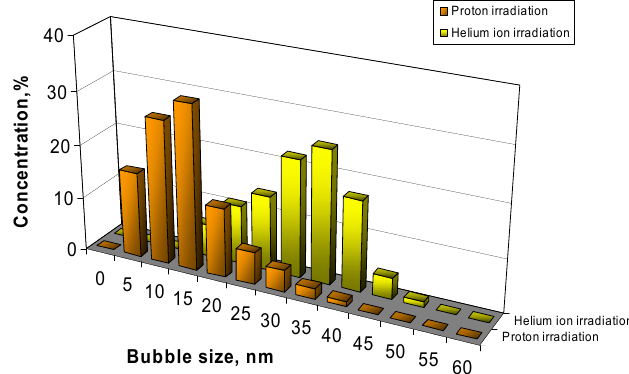
Figure 3. Diagram of changes in the size of gas bubbles on the surface of ceramics at an irradiation dose of 5 × 10 17 ion / cm 2 .